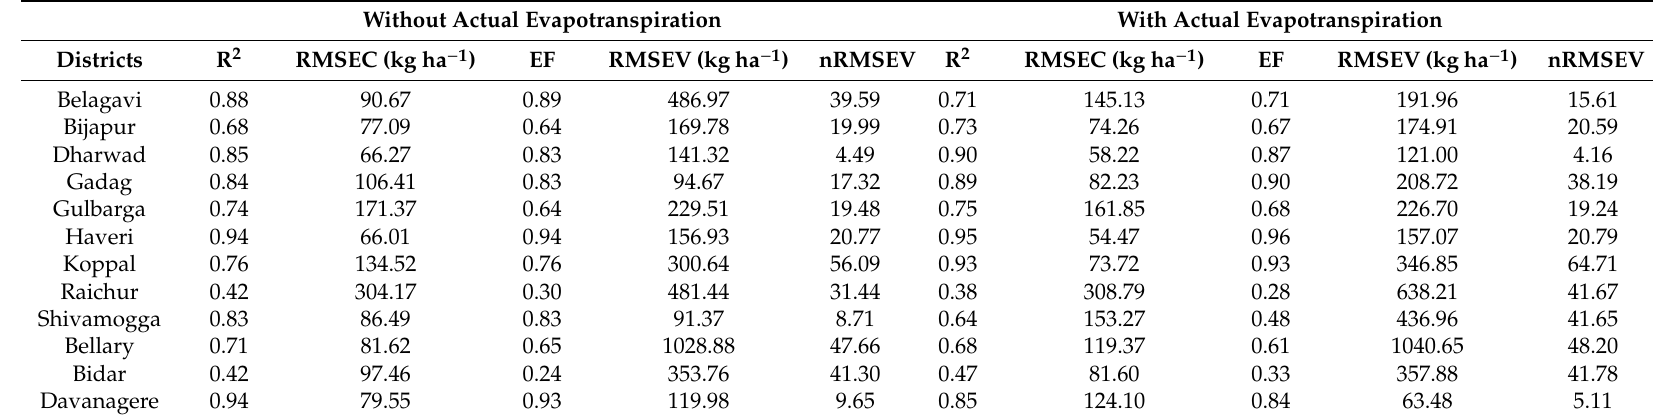
Table 7. Quantitative measures obtained for sorghum yield prediction of Karnataka using